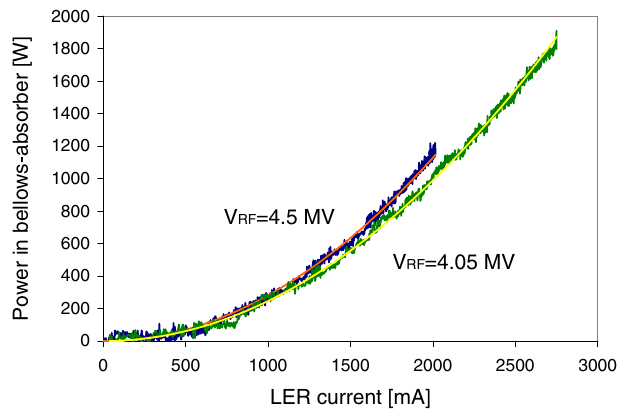
FIG. 17. (Color) Power in the bellows absorber for different rf